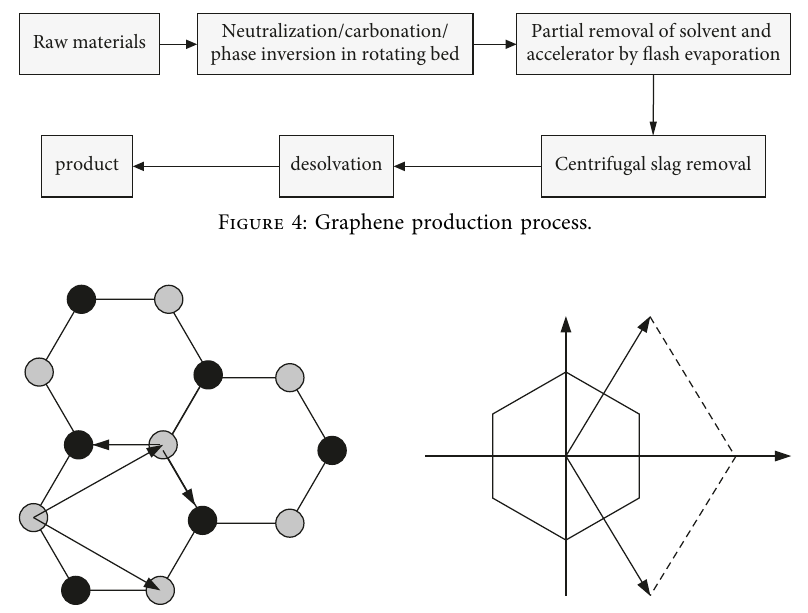
Figure 5: Electronic band energy structure of